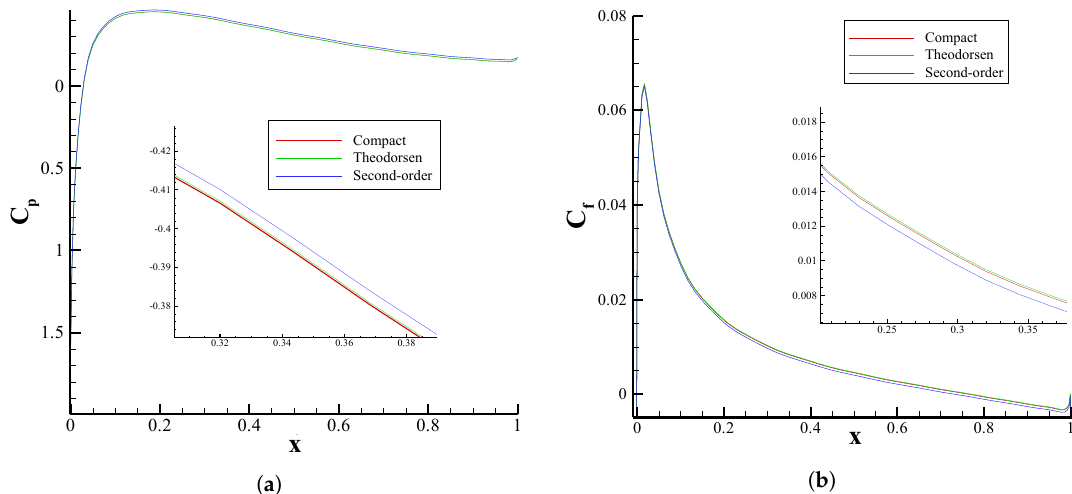
Figure 11. Comparison of the ( a ) pressure and ( b ) skin friction coefficients obtained using the fourth-order compact flow solver with different generated grids, including the standard second-order, compact fourth-order, and Theodorsen techniques, for flow around a NACA 0012 airfoil with Ma = 0.5 and Re = 10 × 10 3 .